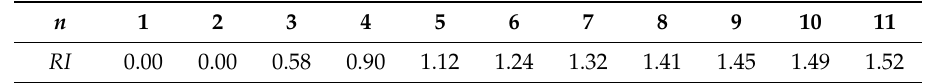
Table 2. n values versus RI